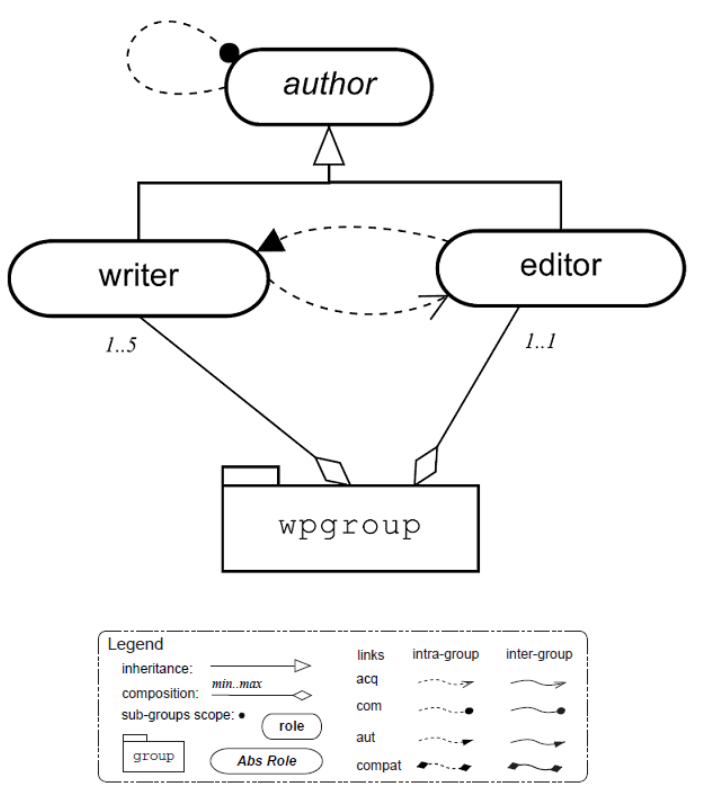
Figure 12. Structural specification for a Writing Paper scenario, based on [52].